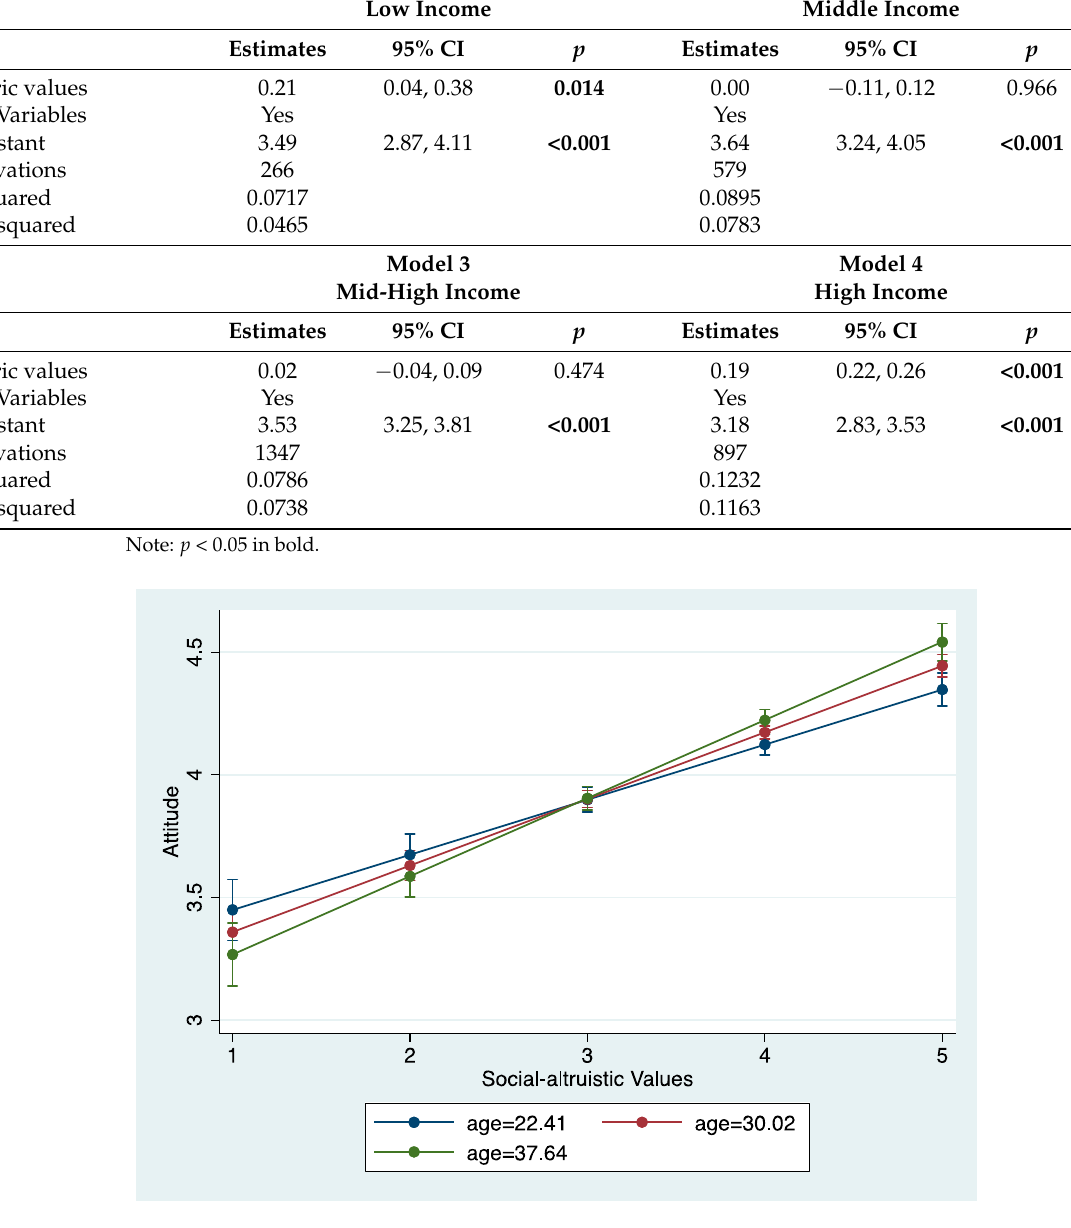
Figure 3. Interaction plot of age and altruistic values on attitudes. Table 7. Moderating effect of age on the relationship between altruistic values and behavioral in- tention.